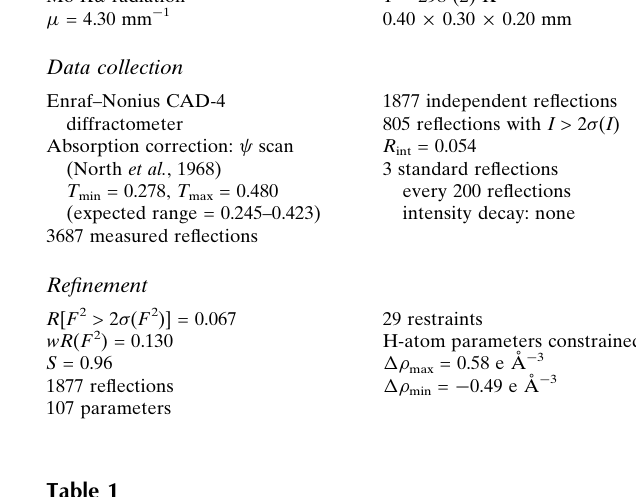
Hydrogen-bond geometry (A˚ , (cid:4)